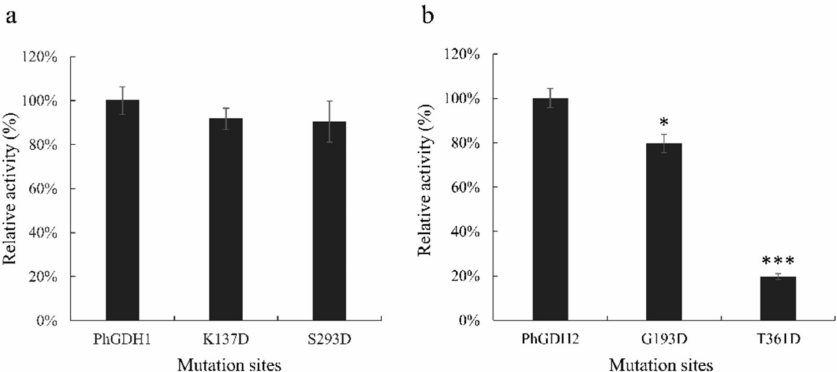
Figure 7. Site-directed mutagenesis. ( a ): Comparisons of the relative activities between recombinant mutant PhGDH1 proteins and wild-type PhGDH1. ( b ): Comparisons of the relative activities between recombinant mutant PhGDH2 and wild-type PhGDH2. Residues involved in the stabilization of the cofactor were replaced by appropriate residues. * p < 0.05 and *** p <